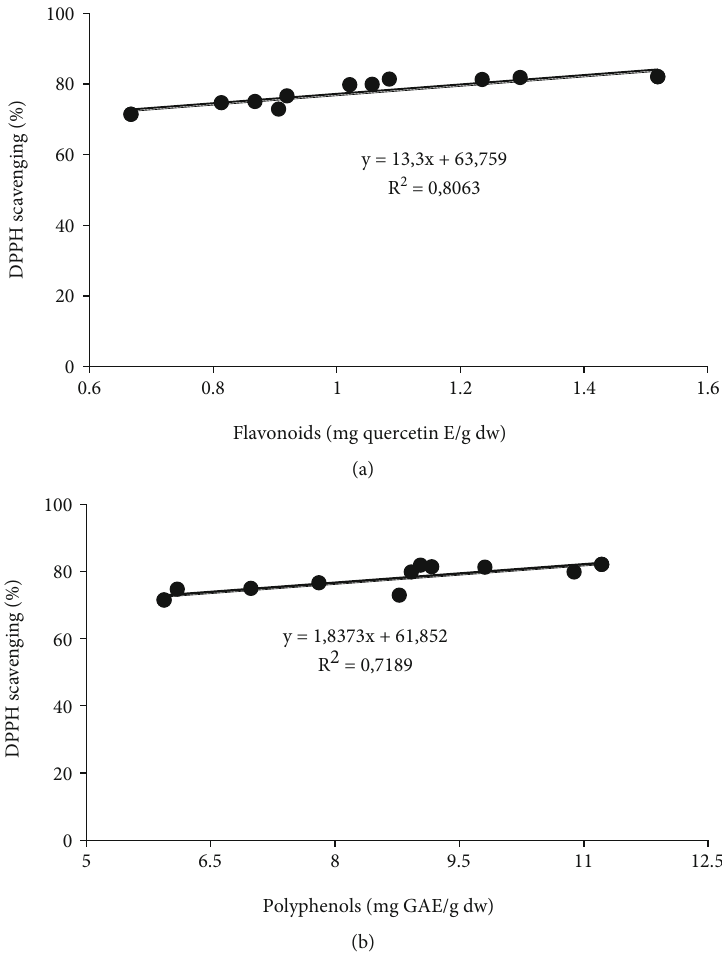
Figure 1: Correlation representation between DPPH scavenging percentage and fl avonoids (a) and polyphenols